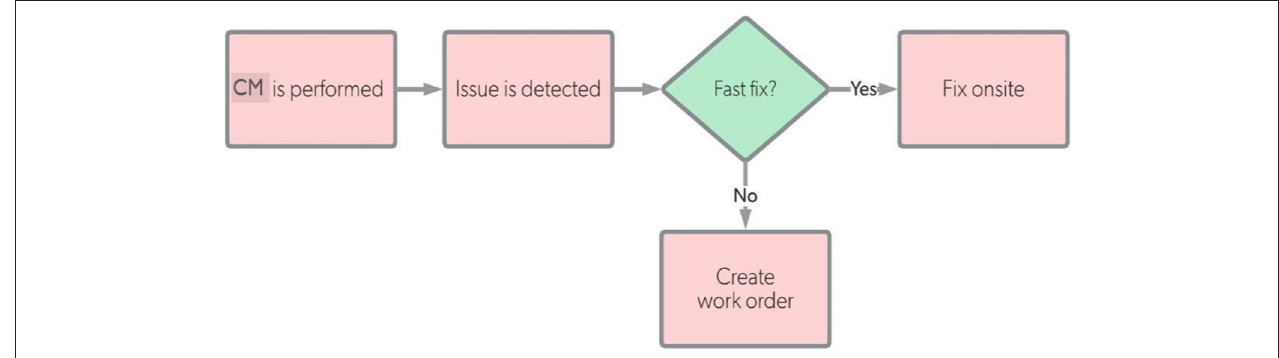
FIGURE 14 | Corrective maintenance workflow for our